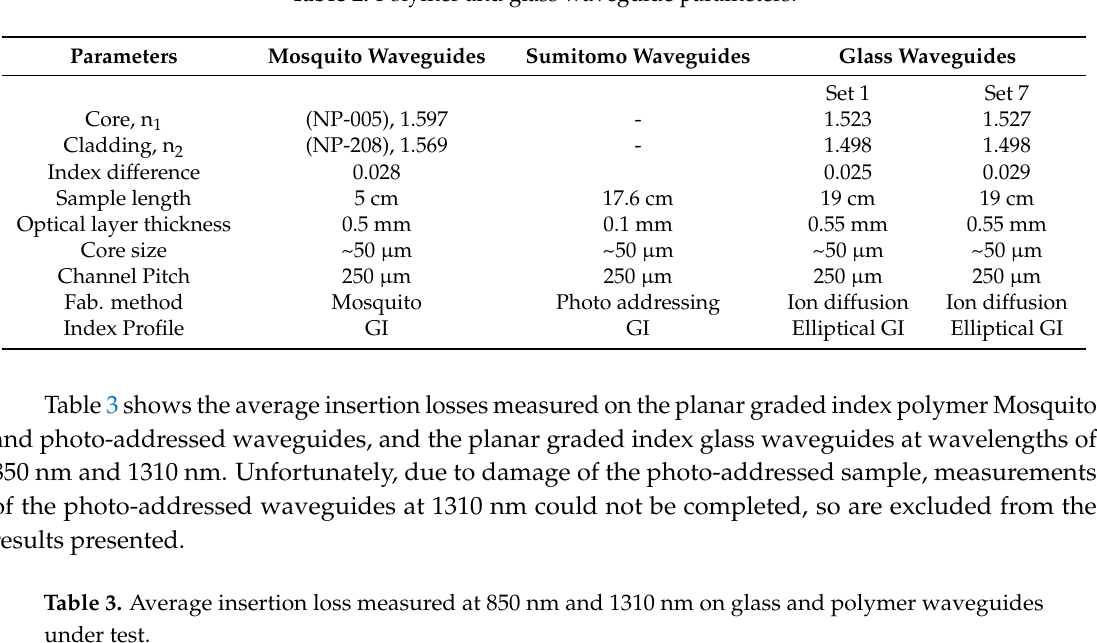
Table 3. Average insertion loss measured at 850 nm and 1310 nm on glass and polymer waveguides under test.